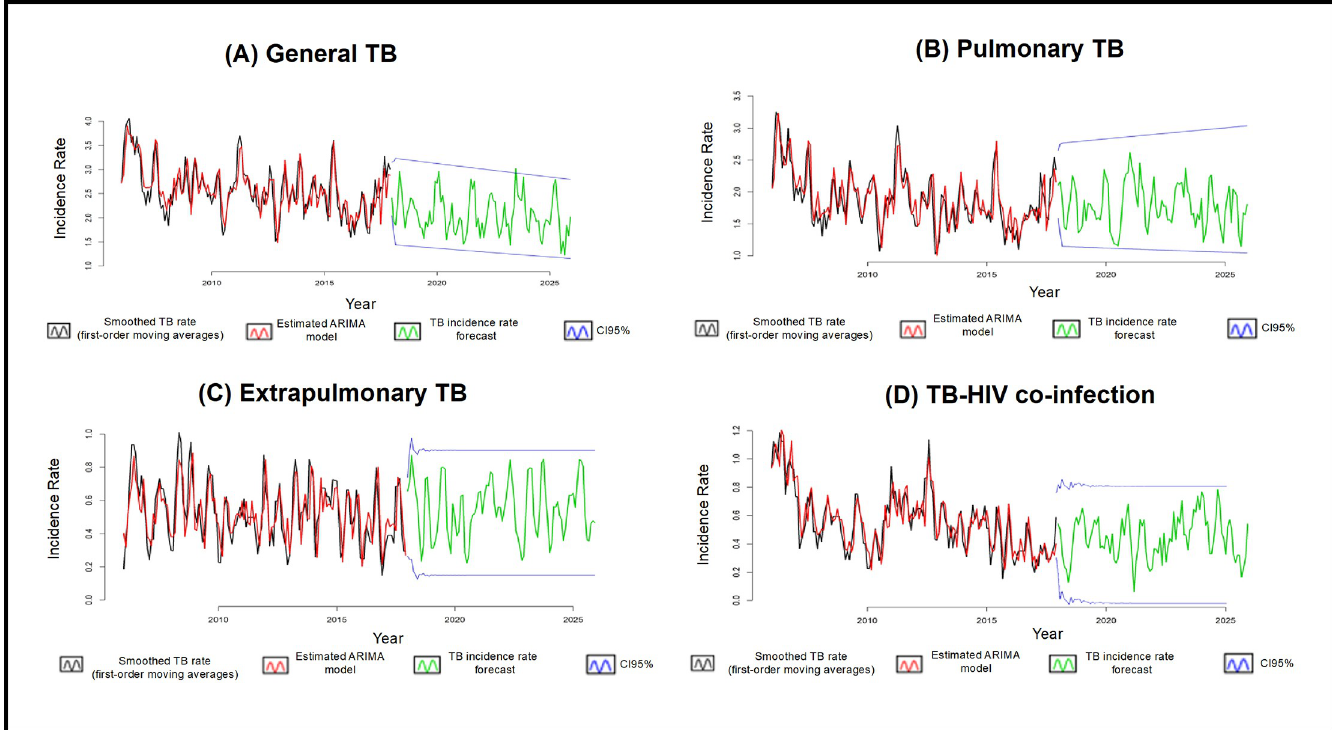
Fig 4. Models adjusted for tuberculosis rates (2006–2017), forecast and respective 95% confidence intervals (2018–2025), Ribeir ã o Preto, S ã o Paulo, Brazil.